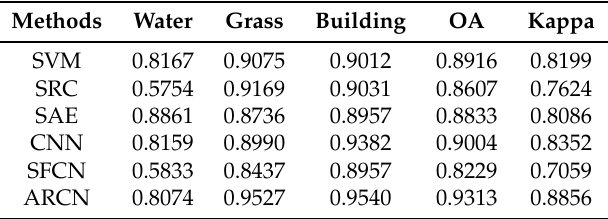
Table 1. Classification results of Xi’an with various methods.